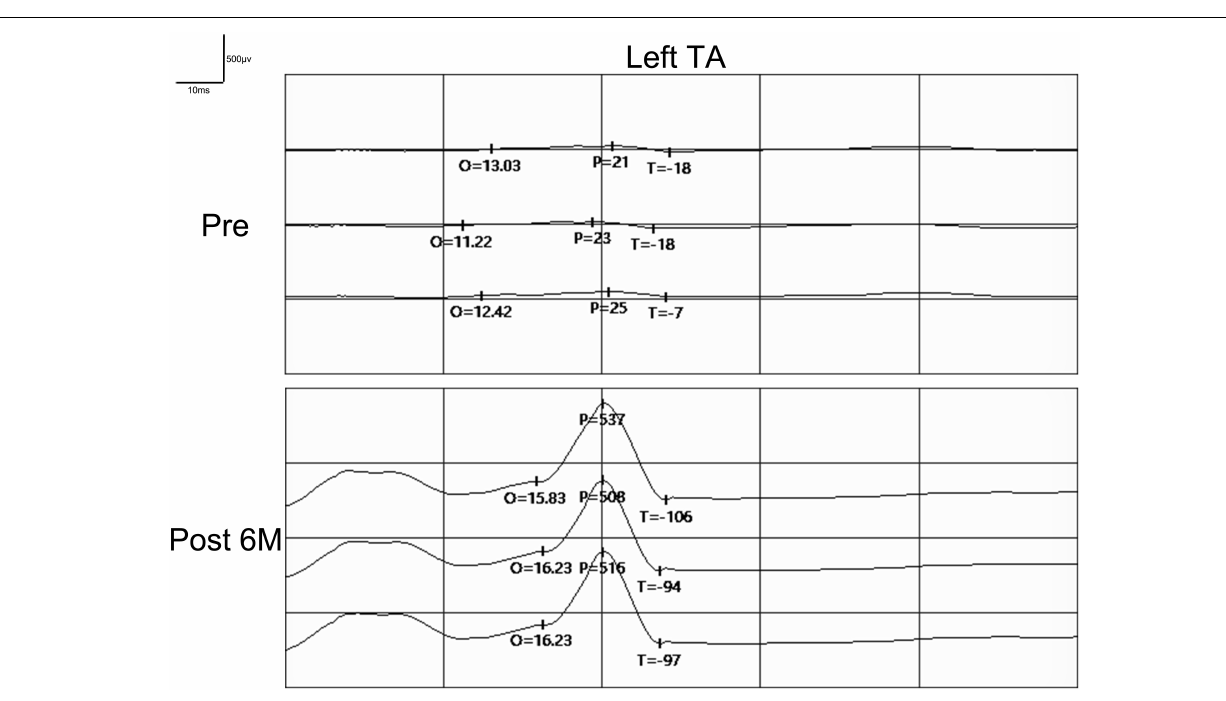
FIGURE 7 | Pre- and postoperative MEPs recorded at tibialis anterior (TA) by transcranial magnetic stimulation in patient SCF010. MEPs recorded at left tibialis anterior showed signs of recovery postoperatively. Pre, Preoperatively; Post, Postoperatively; O, Latency; P,